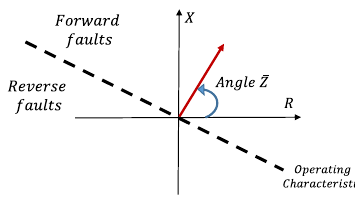
Fig. 8 X-R plane of forward and reverse fault